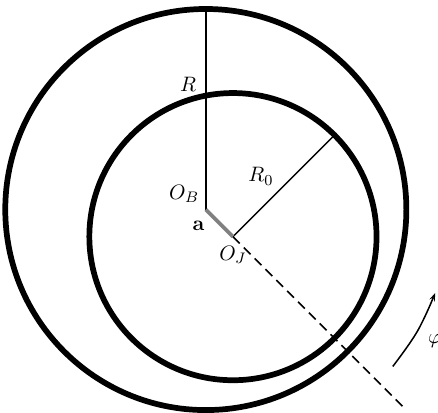
Figure 6. Cross-section of an infinite journal bearing. The journal is centered at O J and rotates counter-clockwise within the fixed bearing centered at O B . The fluid occupies the space between the two cylinders. Reprinted from [14], with permission from Elsevier.